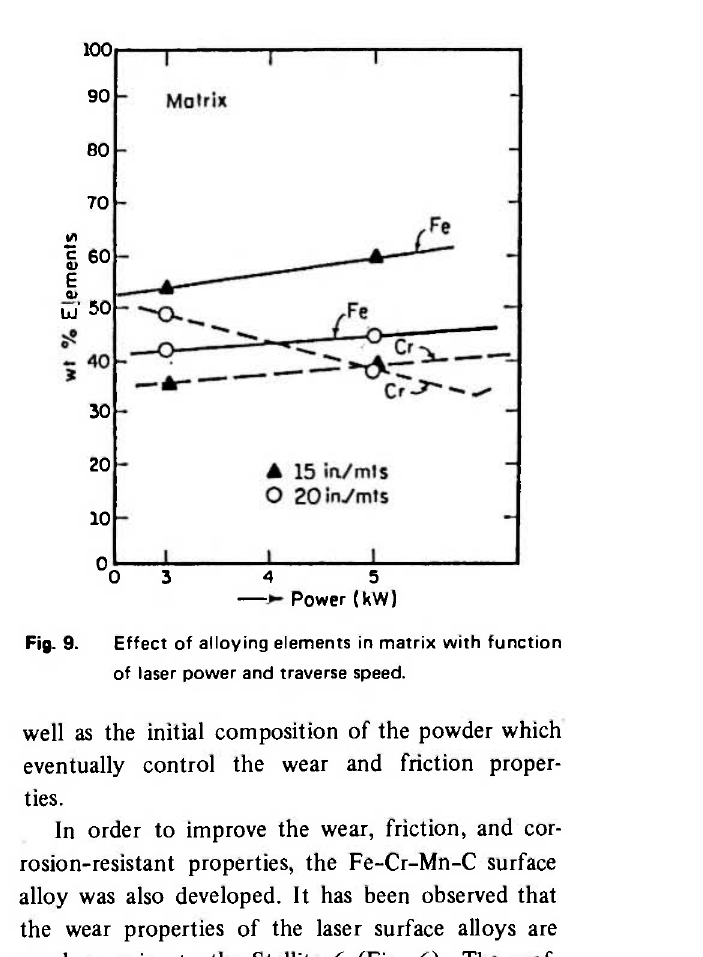
Fig. 9. Effect of alloying elements in matrix with function of laser power and traverse